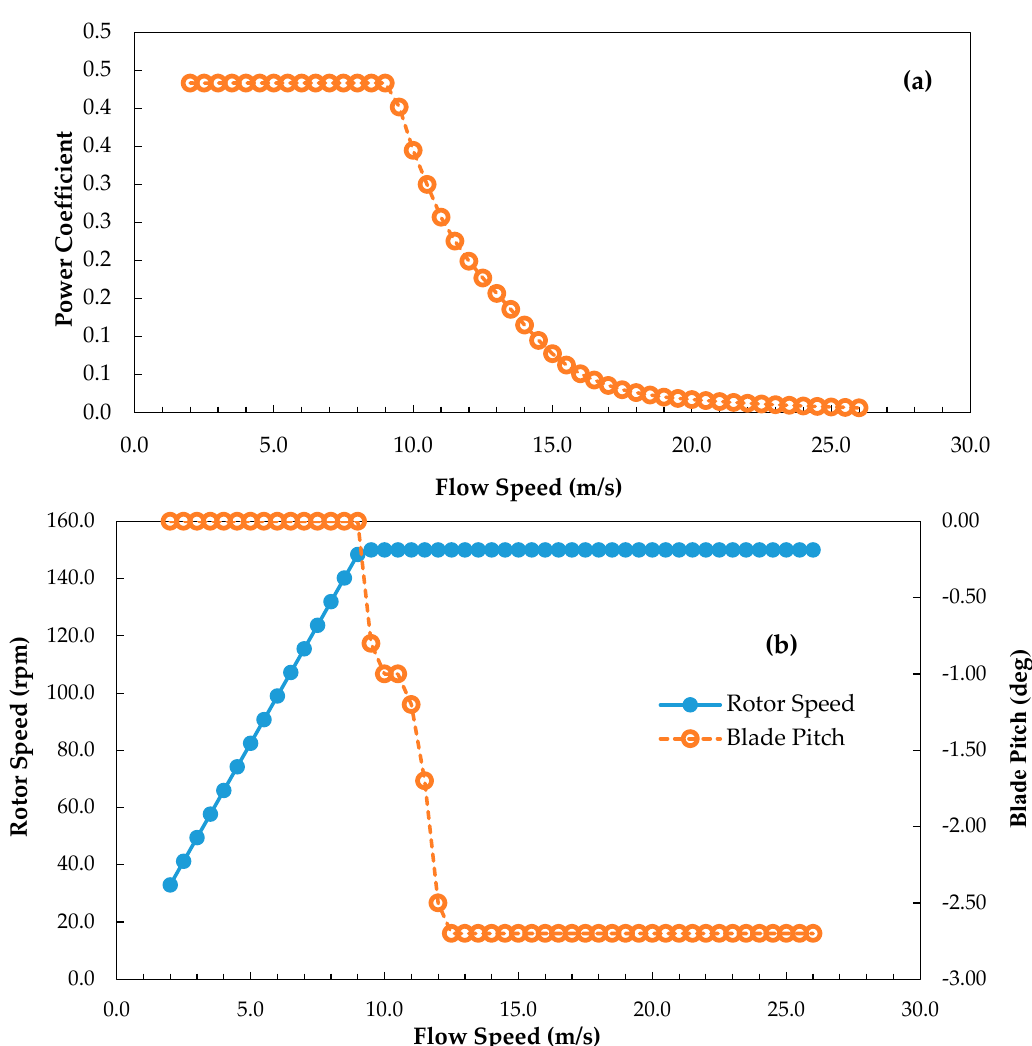
Figure 13. ( a ) Variation of power coe ffi cient with wind speeds. ( b ) Change of rotor speed and pitch Figure 13 . ( a ) Variation of power coefficient with wind speeds. ( b ) Change of rotor speed and pitch angle with wind angle with wind speeds.